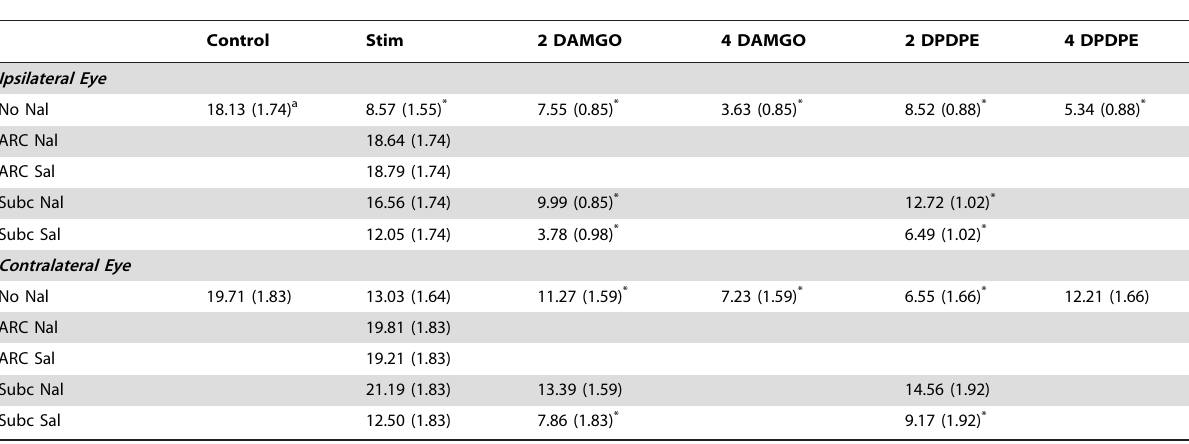
Table 2. Intraocular Pressure during the 35 to 60 min time period.